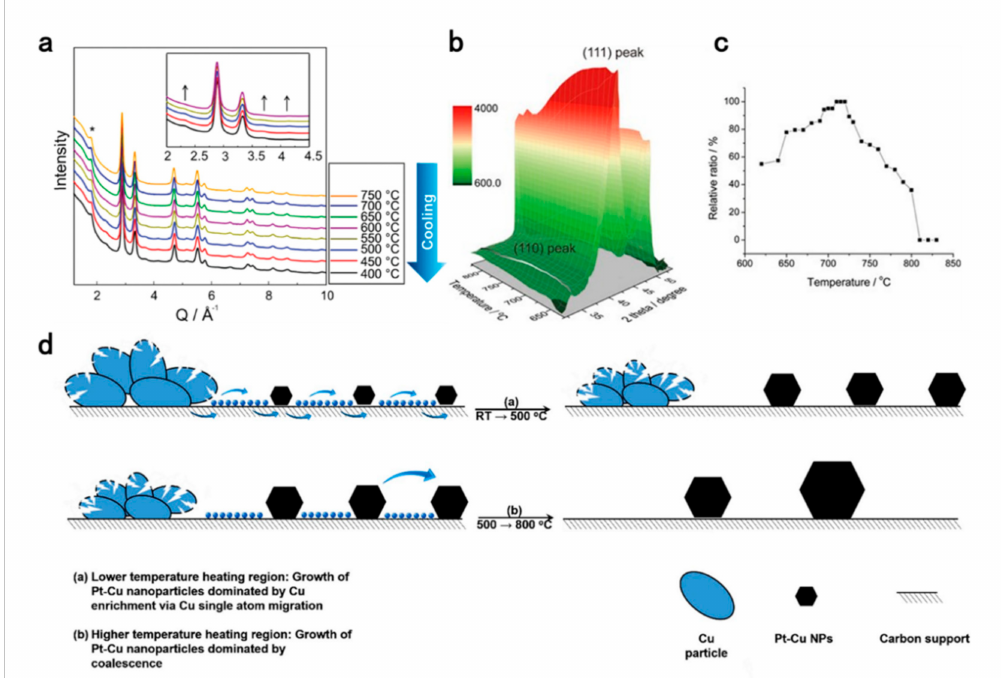
Figure 3. ( a ) In situ HR-XRPD data of PtNi on HGSs recorded during stepwise cooling. Asterisk symbol (*) is used to highlight carbon reflection (HGS support), whereas the arrows (inset) are guides to the eye, indicating the superstructure reflections [62]. Reproduced from Ref. [62] with permission from the Royal Society of Chemistry. ( b ) In situ heating XRD patterns of Pt 3 Co/C annealed from 620 ◦ C to 830 ◦ C at a slow temperature ramping rate of 0.5 ◦ C/min. ( c ) Relative peak integral ratio of the (110) to (111) peaks (with the maximum ratio normalized to 100%) at a series of temperatures [64]. Copyright 2019 National Academy of Sciences. ( d ) Growth mechanisms during heating of PtCu+CuO/C composite [65]. Copyright 2019